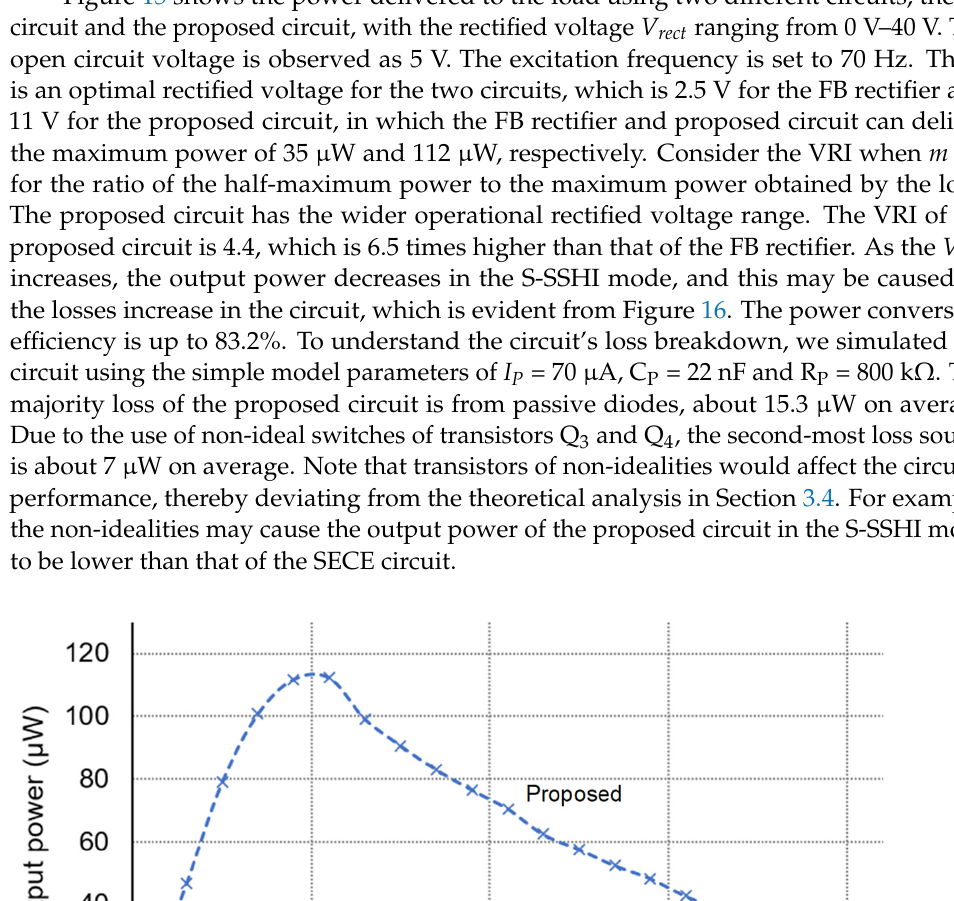
Figure 14. Cold start of the circuit.